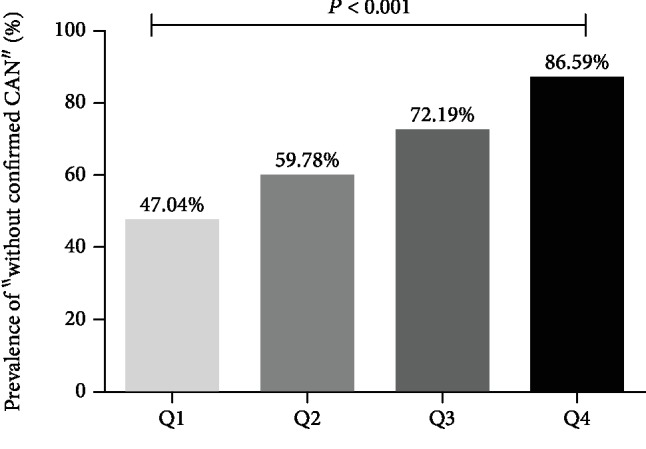
Prevalence of “without confirmed CAN” in different quartiles (Q1-Q4) of TIR. aCAN: cardiovascular autonomic neuropathy. bTIR Q1 ≤ 41%, Q2: 41-64%, Q3: 64-83%, Q4 > 83%. cAs shown in this figure, patients were divided into groups according to quartiles of the time in range (TIR), the proportion of “without confirmed CAN” increased with the increase of TIR, (P < 0.001). P value for the significant difference among the groups was determined by χ2-test.